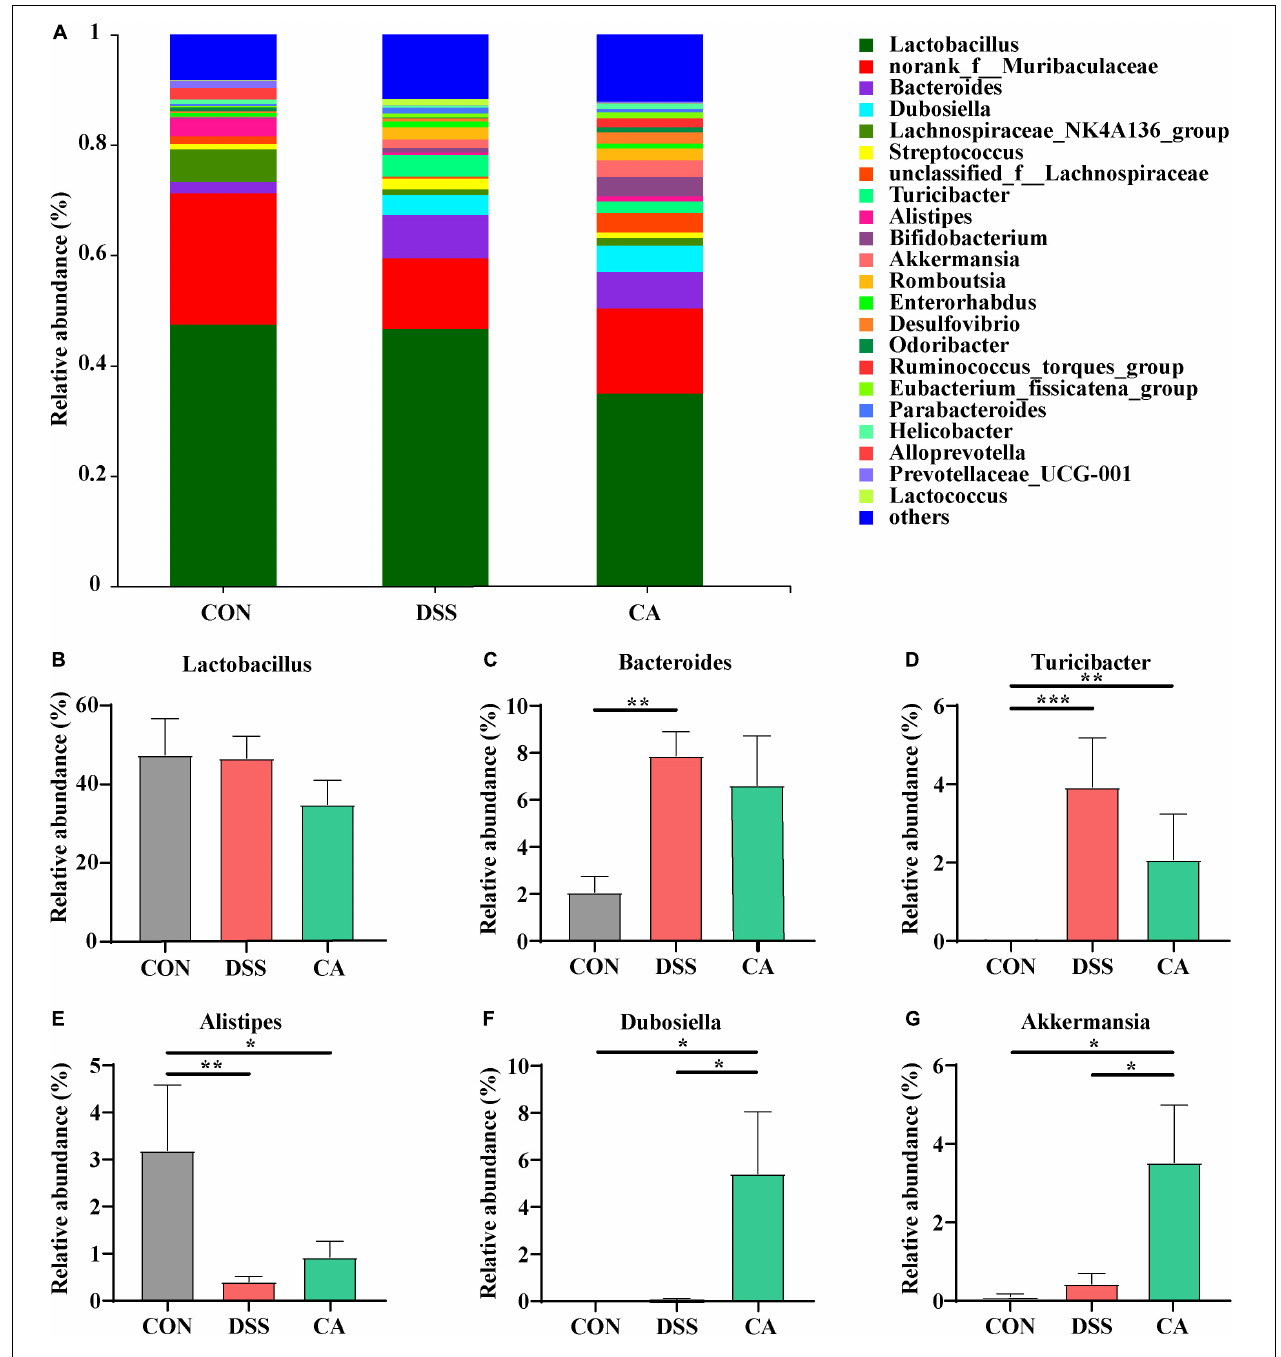
FIGURE 6 | Effects of CA administration on intestinal microbiota inflammatory in DSS-induced colitis mice. (A) Structural comparison of intestinal microbiota between the CON, DSS, and CA groups at genus levels. (B) Relative abundance of Lactobacillus (C) relative abundance of Bacteroides . (D) Relative abundance of Turicibacter . (E) Relative abundance of Alistipes . (F) Relative abundance of Dubosiella . (G) Relative abundance of Akkermansia . Data are presented as mean ± SEM. ( n = 8 mice). Groups with different letters statistically differ. * p < 0.05, ** p < 0.01, and *** p <